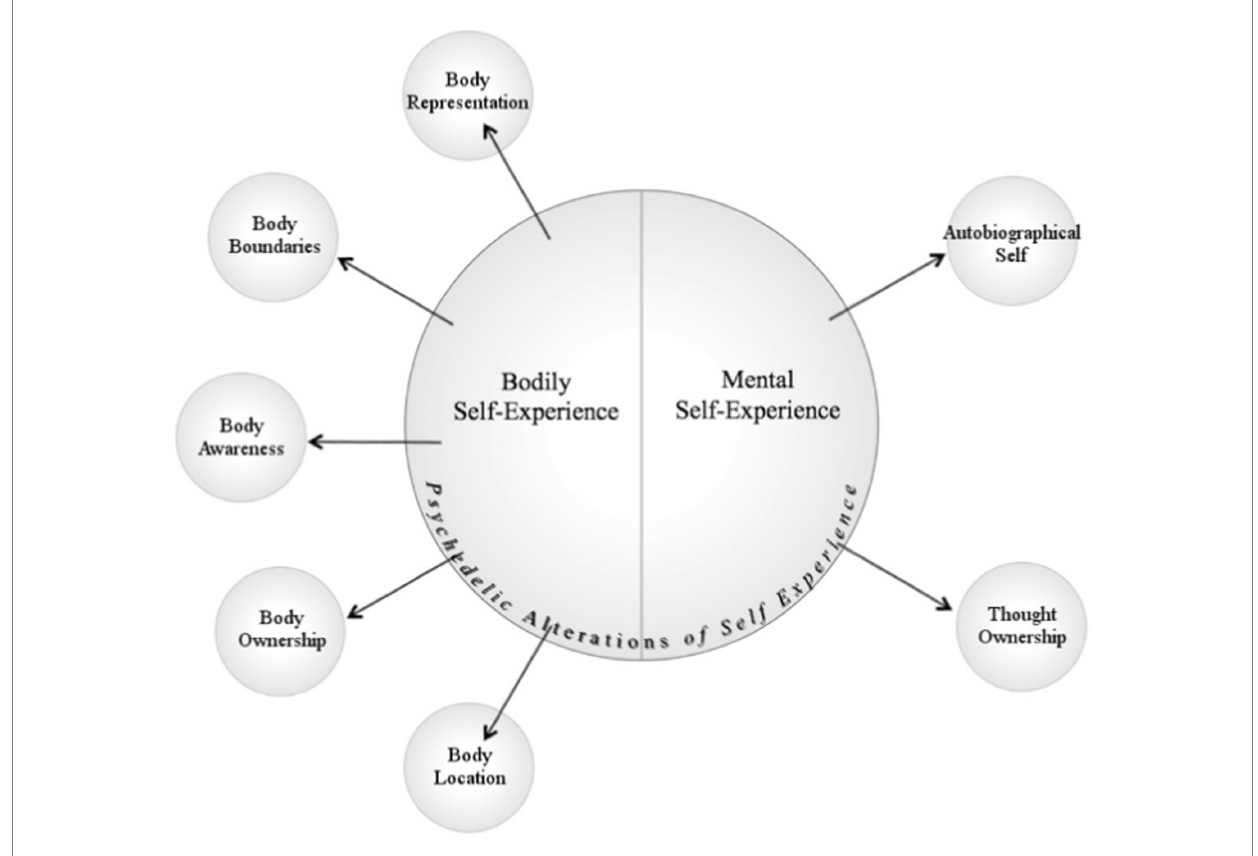
FIGURE 1 Components of self-experience altered by psychedelics. Adapted from